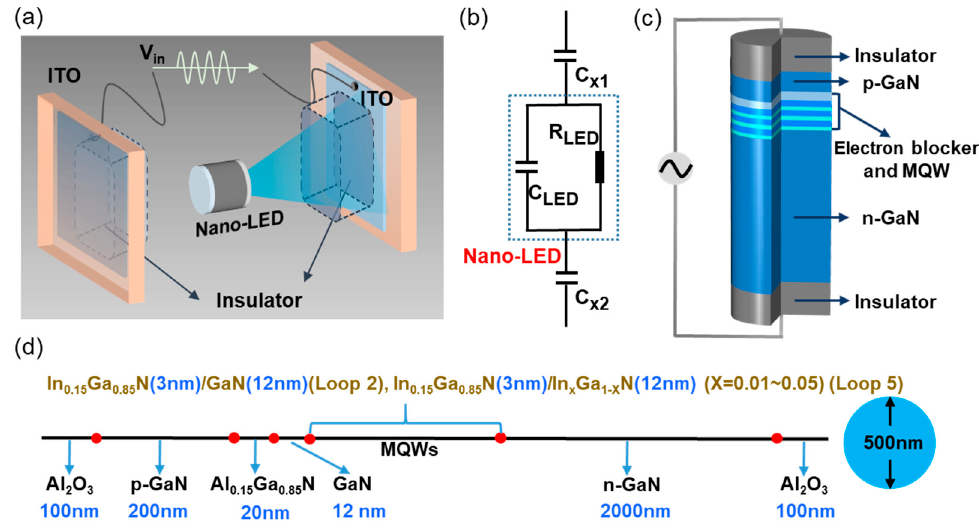
Figure 2. Schematic diagram of the nano-LED operating in NEC&NCI mode and the finite model for simulation. ( a ) Schematic of the nano-LED operating in the NEC&NCI mode. ( b ) Equivalent circuit of the device. ( c ) Finite model for simulation. ( d ) Structural parameters of the model.